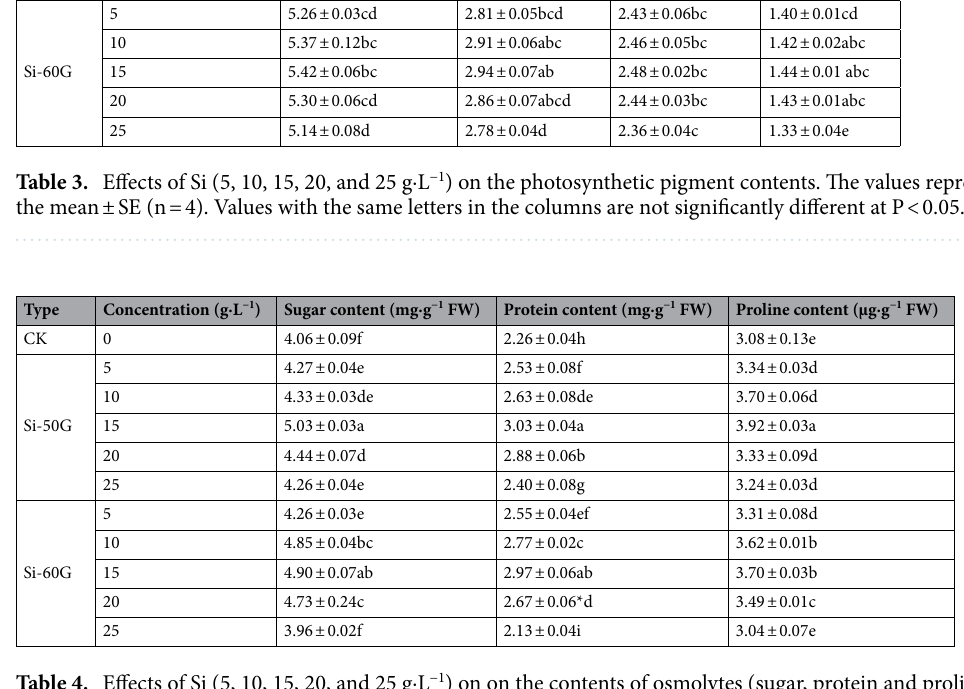
Table 4. Effects of Si (5, 10, 15, 20, and 25 g·L −1 ) on on the contents of osmolytes (sugar, protein and proline). The values represent the mean ± SE (n = 4). Values with the same letters in the columns are not significantly different at P < 0.05.